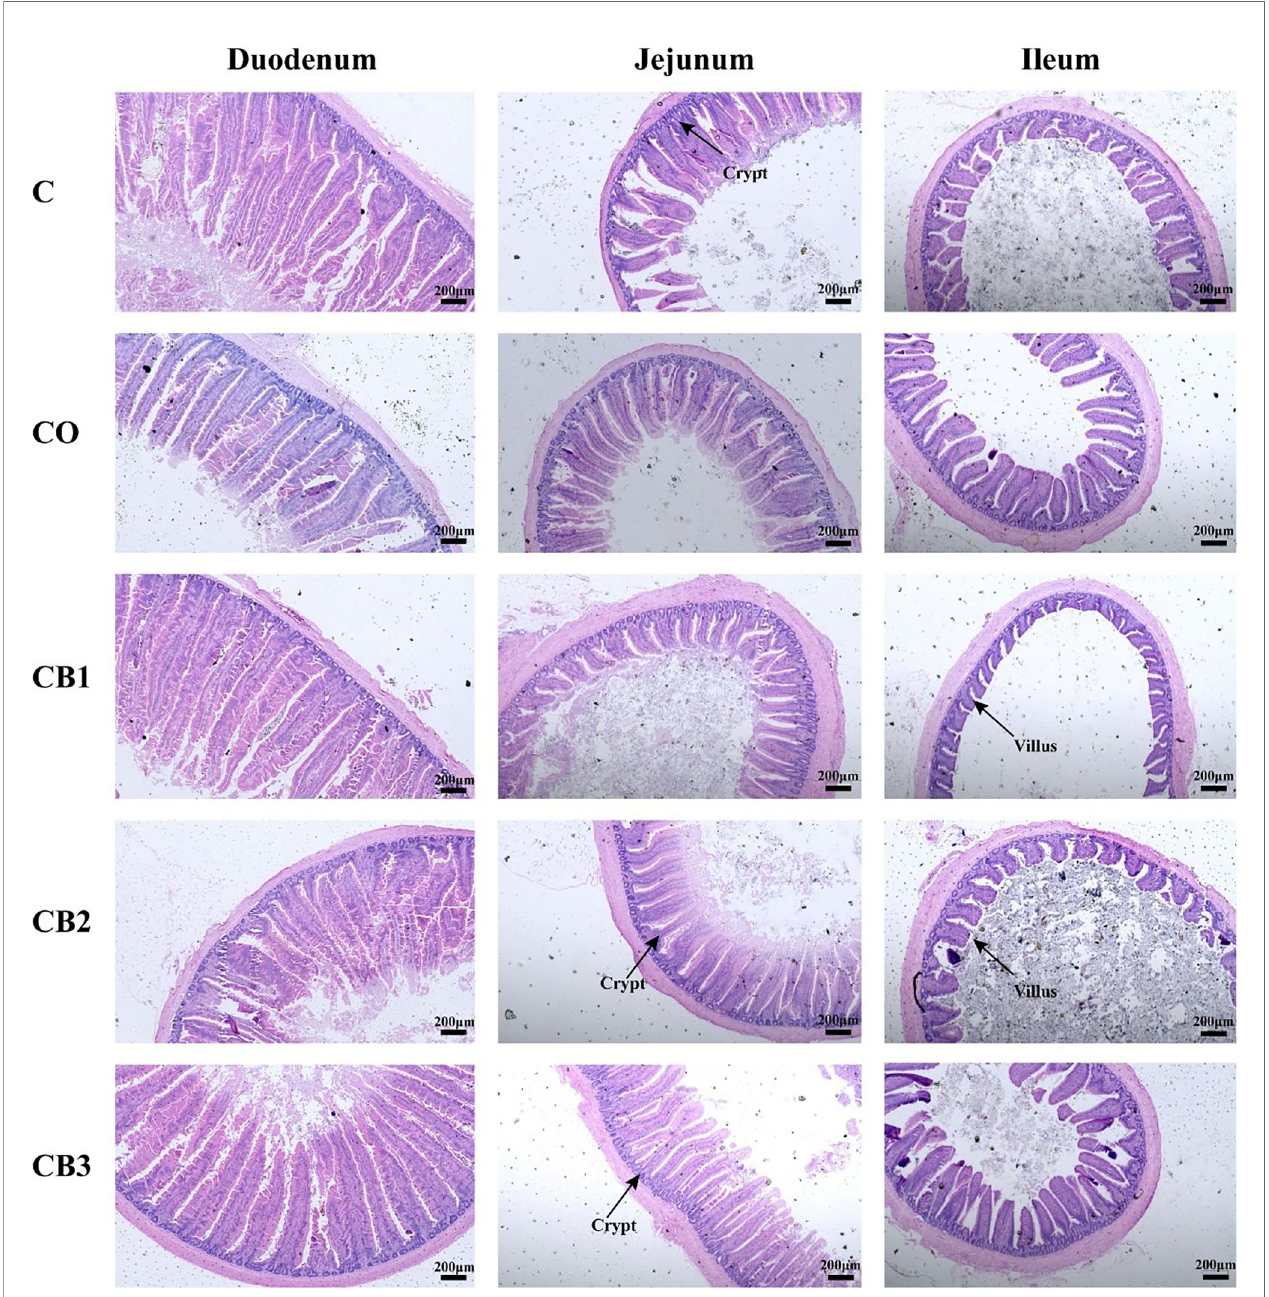
FIGURE 2 | Effects of dietary chitosan oligosaccharides (COS) and Clostridium butyricum synbiotic supplementation on intestinal morphology of duodenum, jejunum, and ileum in early-weaned pigeon squabs. Sections were stained with H&E. C group, control group, squabs fed with arti fi cial crop milk; CO group, squabs fed with arti fi cial crop milk + 150 mg/kg COS; CB1, CB2, and CB3 group, squabs fed with arti fi cial crop milk + 150 mg/kg COS + 200, 300, and 400 mg/kg C. butyricum ,